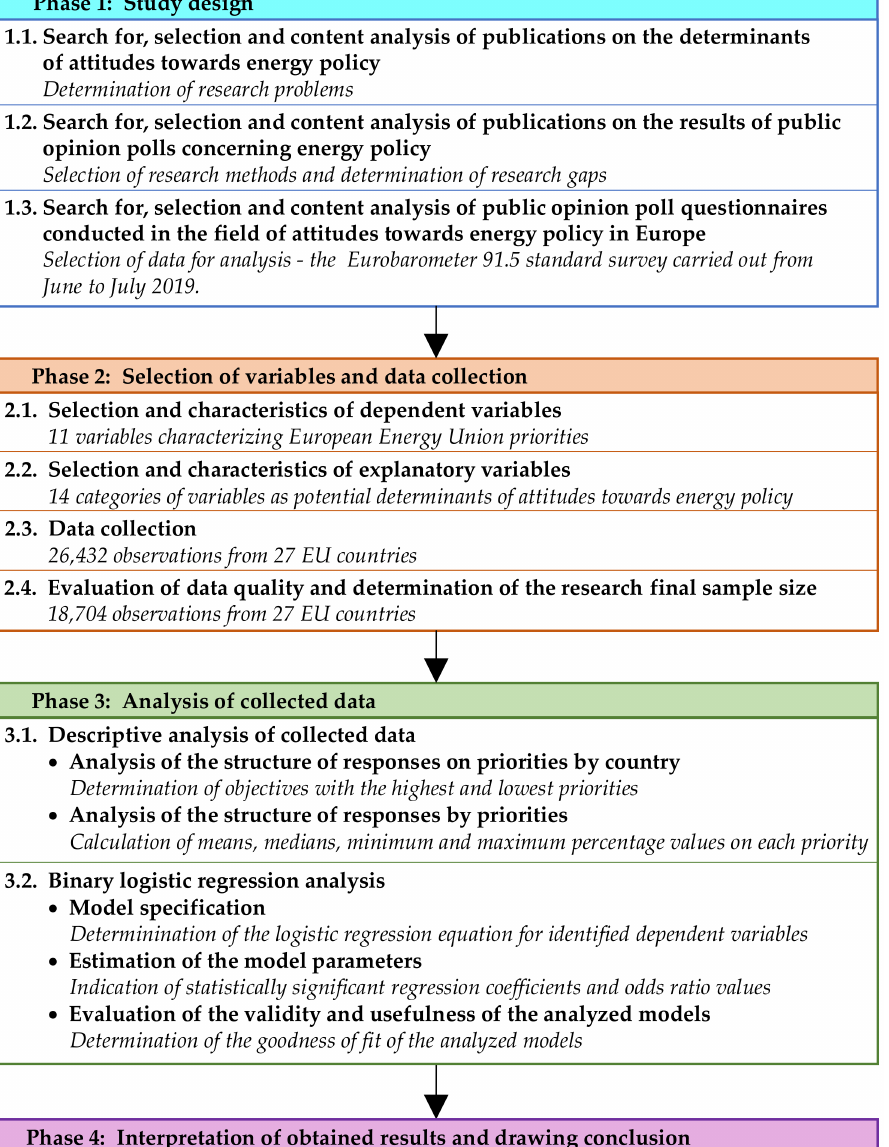
Figure 1. Research